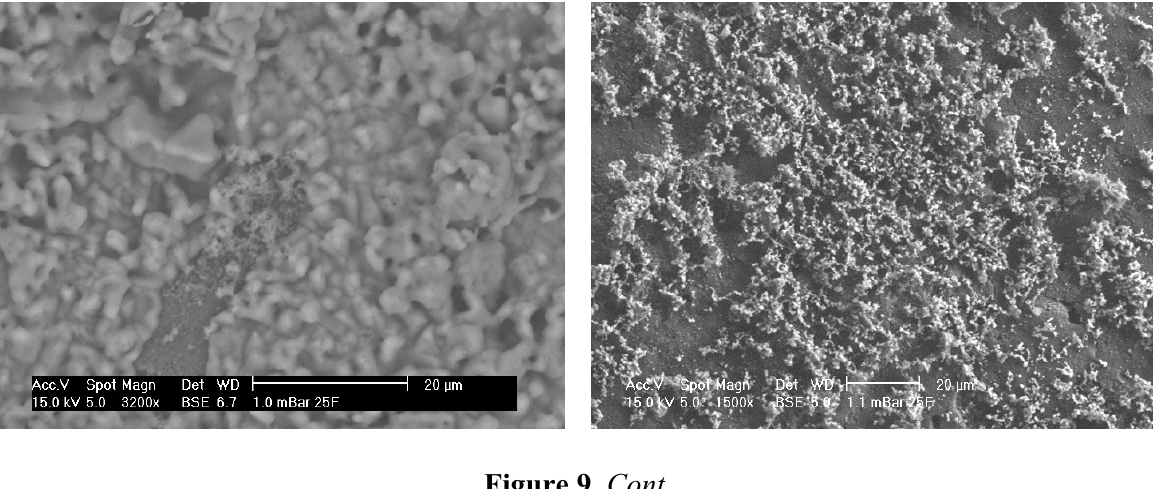
Figure 8. SEM and EDS of before ( left ) and after ( right ) heat treatment of coating at 950 °C for porous Sample A alumina. Sodium and chlorine are no longer present after heat